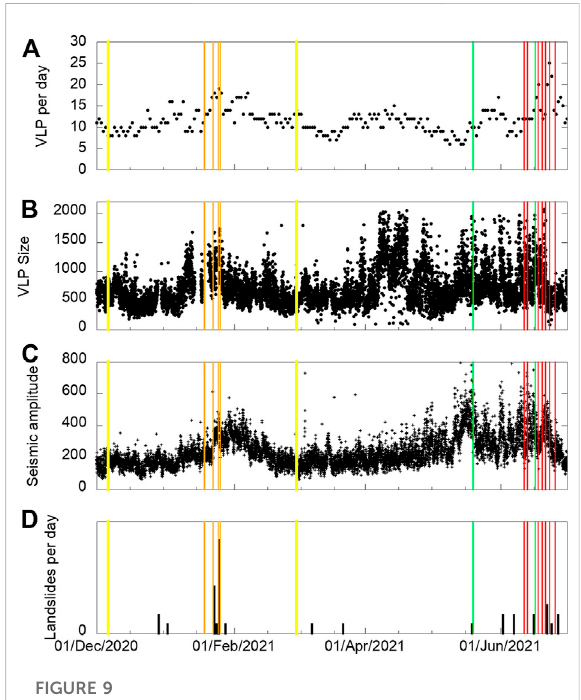
FIGURE 9 Time evolution of the hourly rate of VLPs on a daily basis (A) ; VLP size in counts (B) ; seismic amplitude in counts (C) and landslide daily rate (D) . Vertical bars indicate major explosions (yellow); lava fl ows (red); spattering and over fl ows (orange) and fl ank failure and PDC